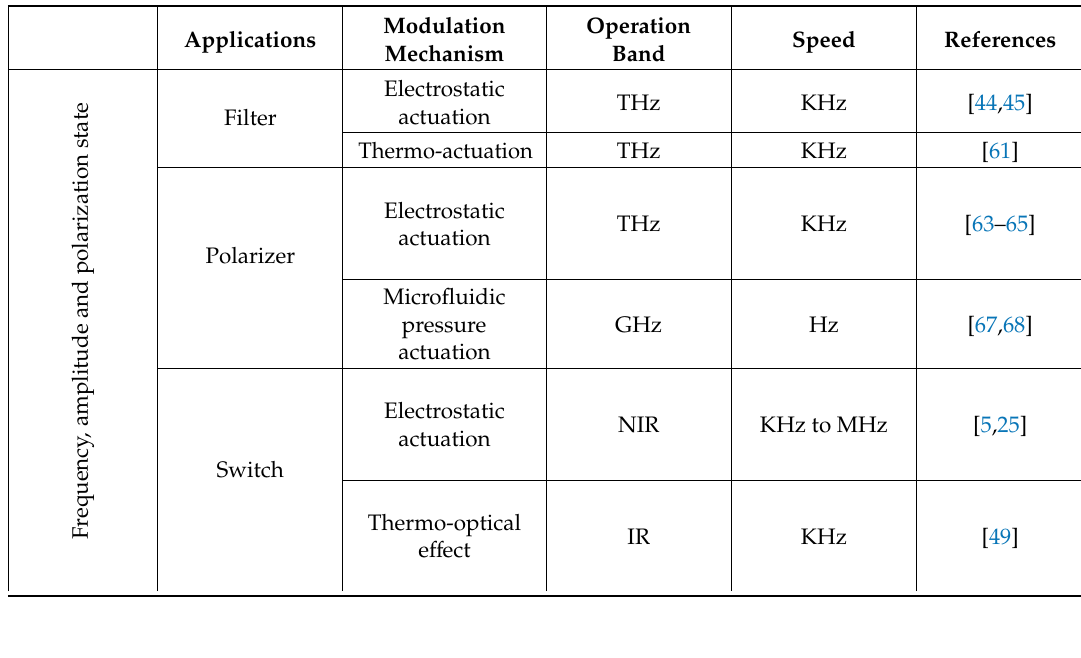
Table 1. Summary of the applications of microelectromechanical systems (MEMS) metasurfaces based on modulation mechanism, operation band, and tuning